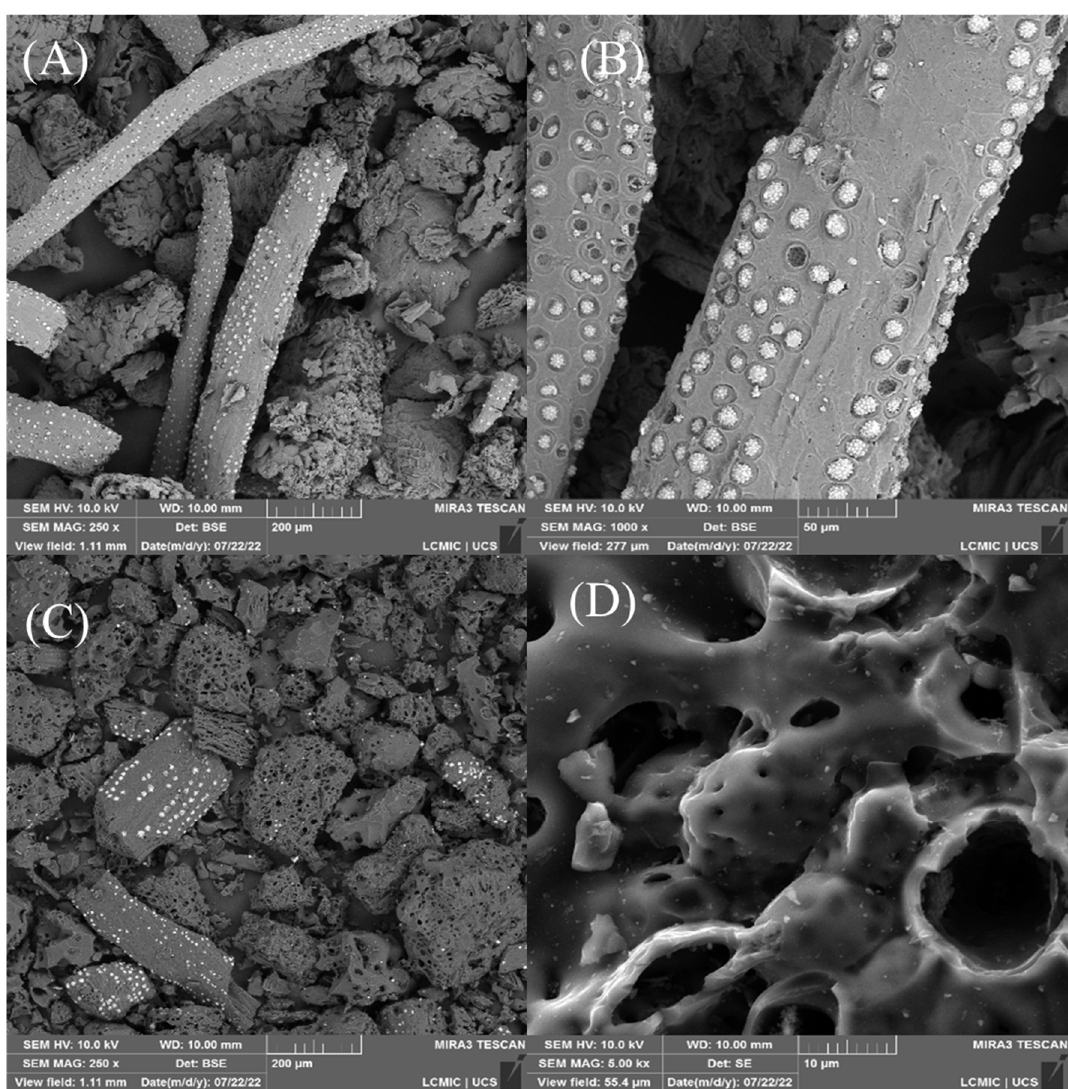
Figure 1. Micrographs of the material surface before ( A , B ) and after carbonization ( C , D